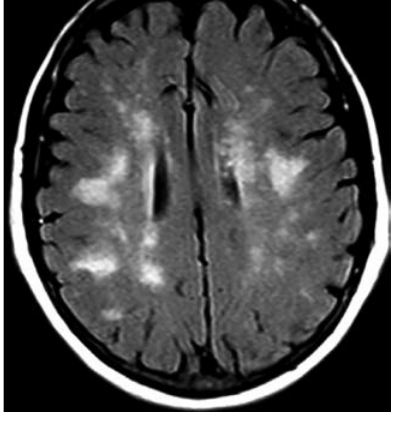
Figure 10. Brain magnetic resonance imag- ing of an asymptomatic 54-year old female showing multifocal leukoencephalopathy ( Reprinted with permission of the publish- er from Buechner et al. 68 ).